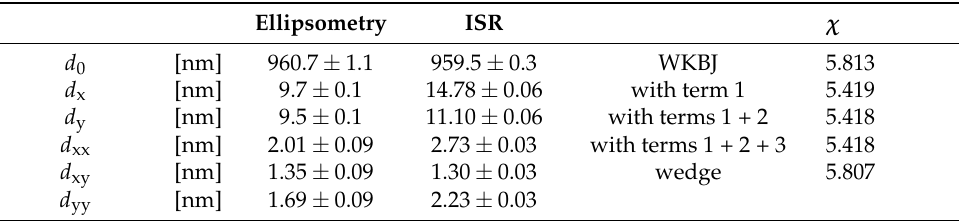
Table 1. Values of the parameters describing the thickness nonuniformity of the characterized film of SiO x C y H z (left). Values of quantity χ for the individual total corrections in the formulae for the reflection coefficients of the inhomogeneous SiO x C y H z thin film (right). Ellipsometry ISR χ d 0